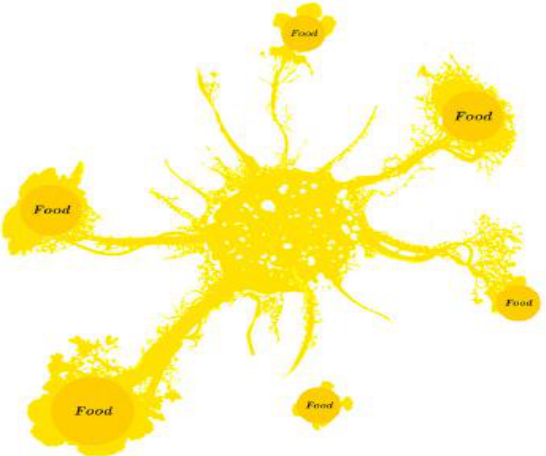
Figure 5. The foraging behavior of slime mold in nature (adapted from [44]).